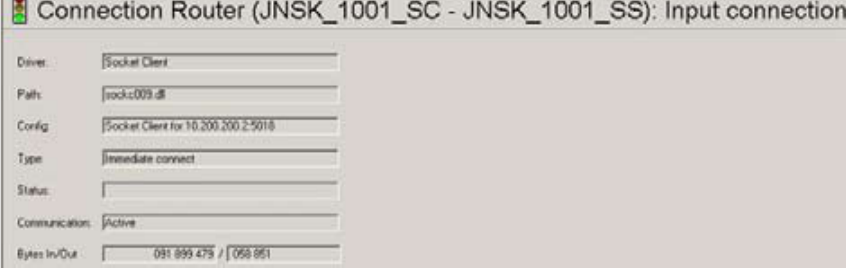
Fig. 6. Example of connection router to station